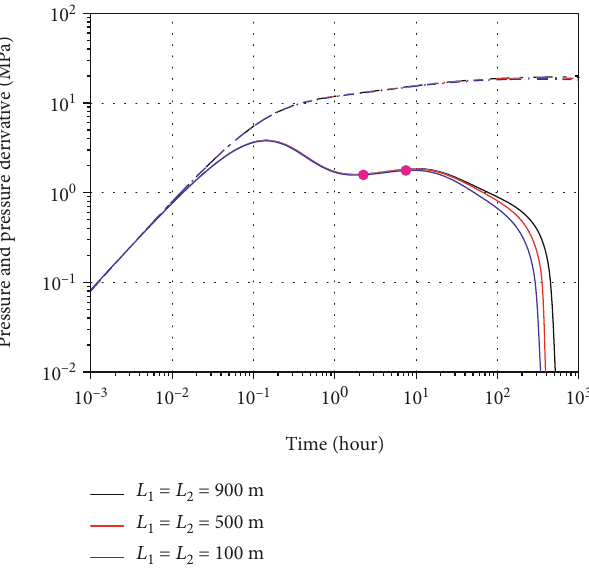
Figure 16: E ff ect of the rate of the adjacent injector on pressure transient response. q and q are the rates of adjacent injectors. 1 2